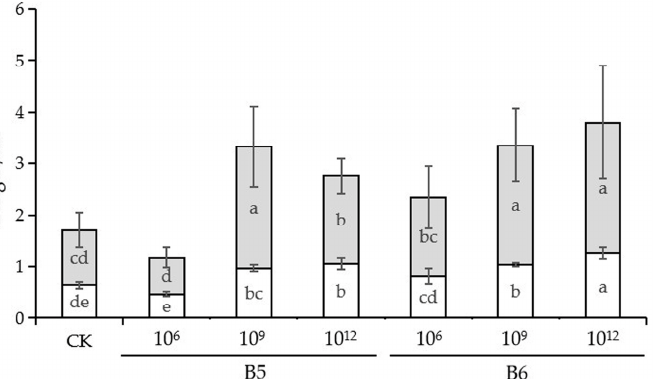
Figure 3. The hypocotyl length (white rectangle) and taproot length (grey rectangle) under different treatments. Different lowercases indicated statistical difference at p < 0.05. Table 2. Effect of B5 and B6 suspension at different concentrations on cabbage seed germination.